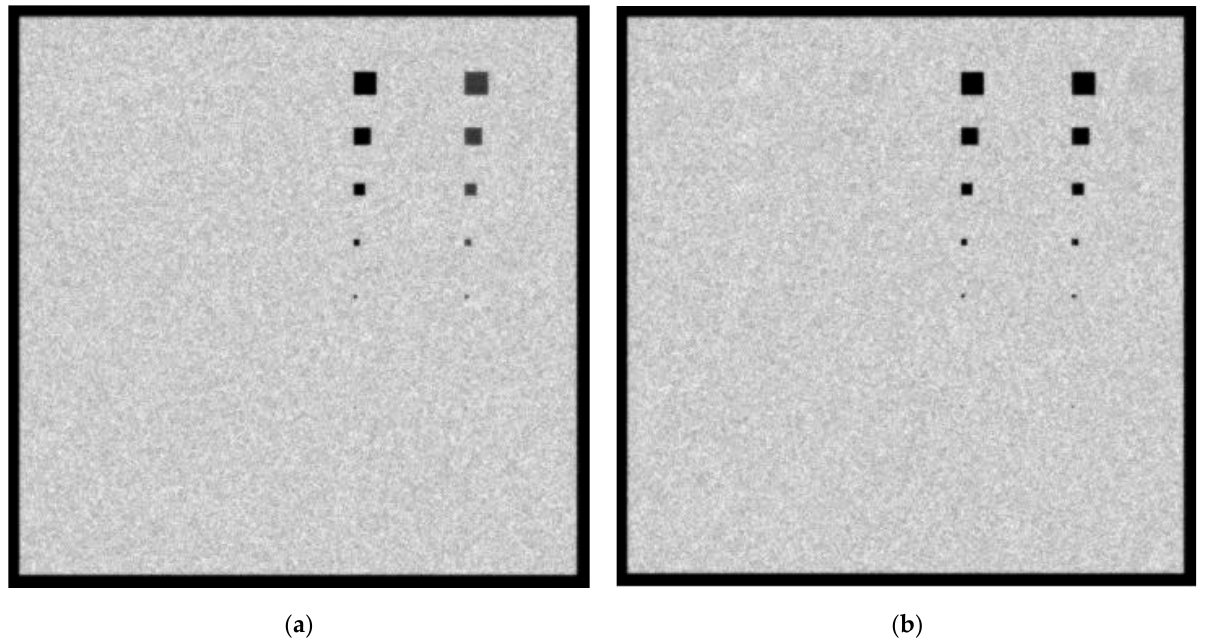
Figure 12. A 6 cm phantom image for W/Rh 5 mGy and 32 kVp spectrum with ( a ) 0.1 cm lesion thickness and ( b ) 0.5 cm lesion thickness.